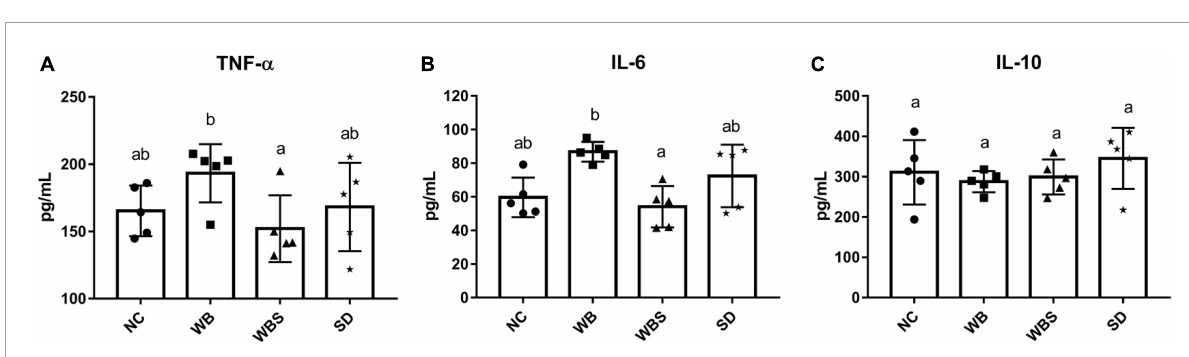
FIGURE5 Cytokine assay of colon tissue of the in vivo mouse model in each group. (A) TNF- α . (B) IL-6. (C) IL-10. Error bars present the standard deviations of five replicates ( n = 5 male mice). One-way ANOVA followed by Duncan’s post-hoc analysis, and bars with different letters indicate significant differences at p <